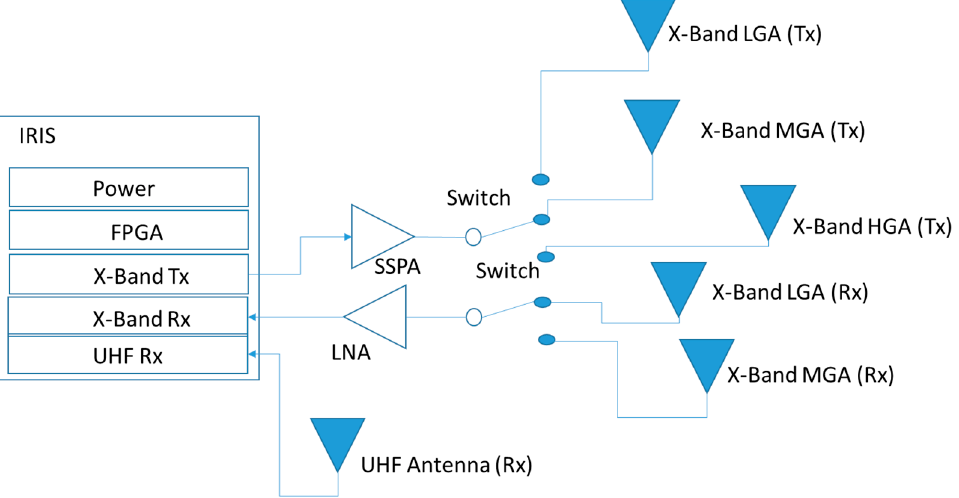
Figure 4. MarCO block diagram.